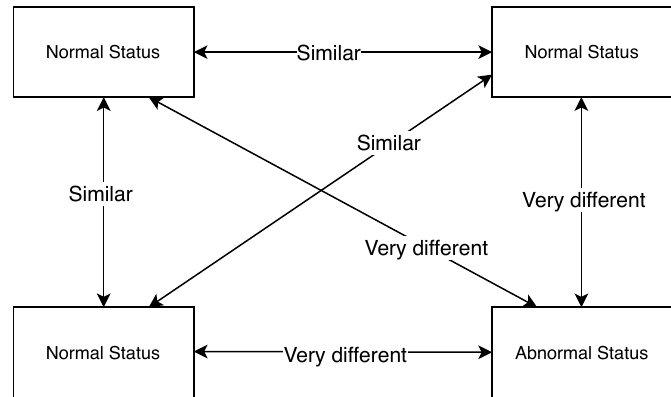
Figure 1. The assumption to use the components running normally to detect the faulty components with the same